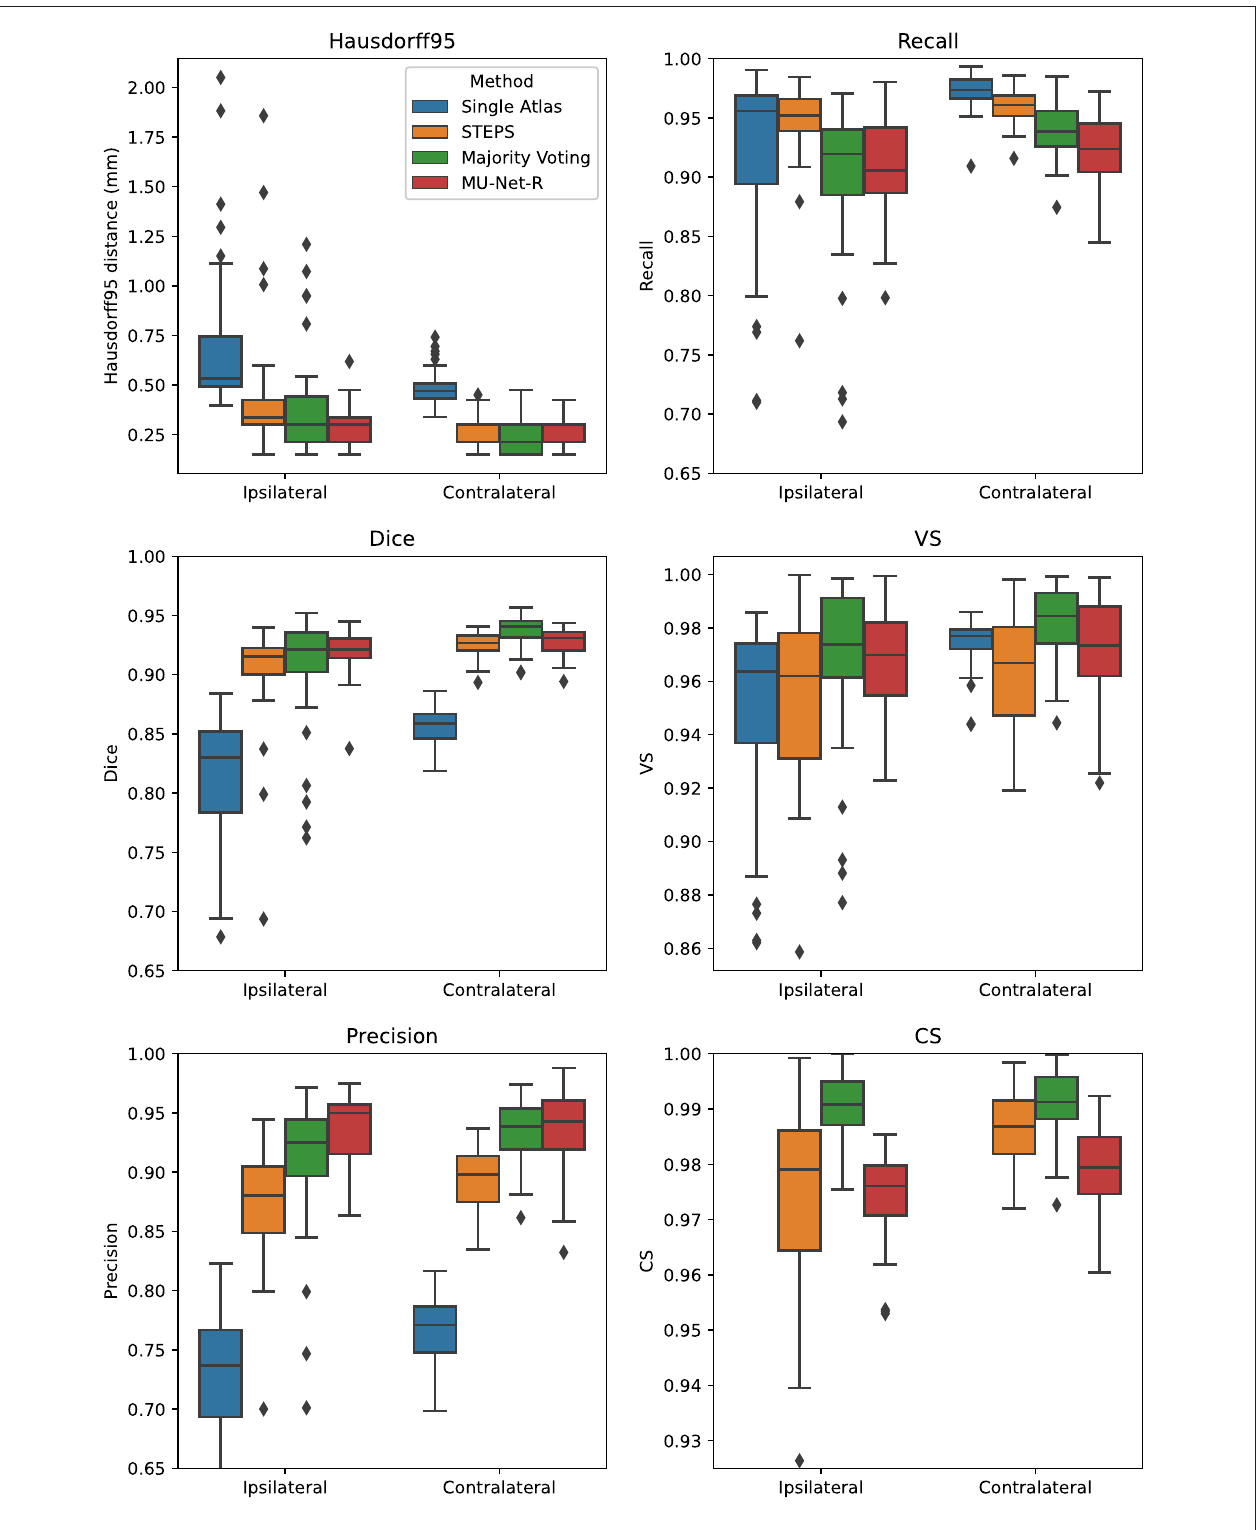
FIGURE 4 | Box plots of all measured quality metrics for the contralateral and ipsilateral hippocampus in the EpiBioS4Rx dataset. Single atlas CS measures (not displayed) average at 0.60 for both hippocampi with a standard deviation of 0.01. Contrary to single-atlas segmentation, MU-Net-R and multi-atlas methods achieve human-level